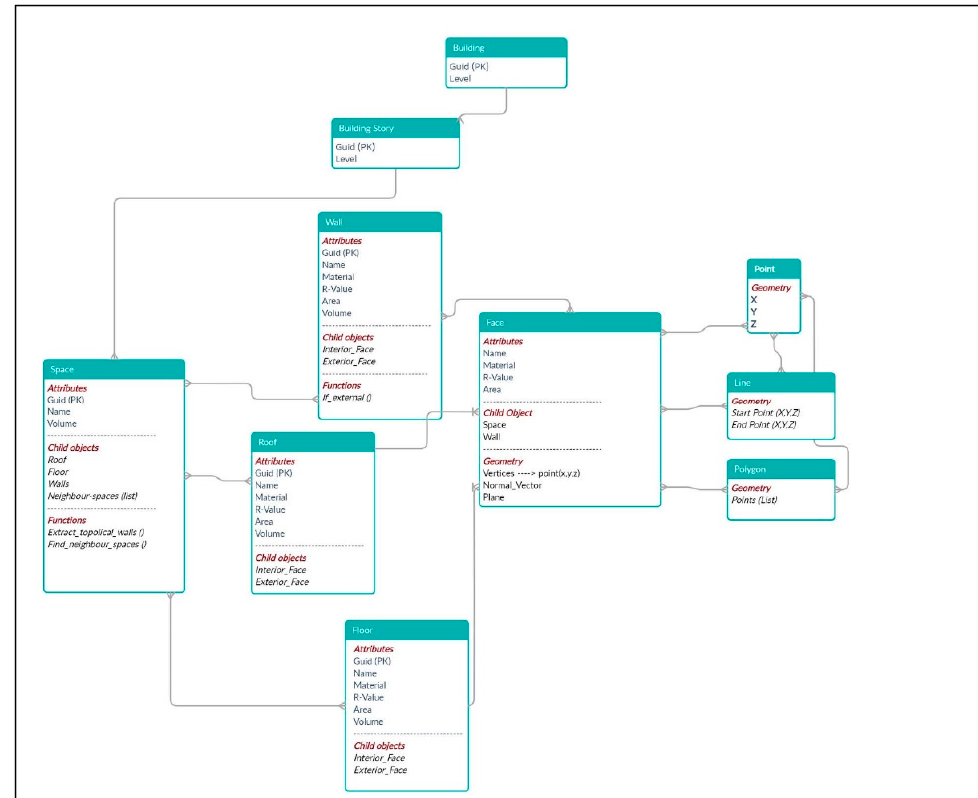
Figure 5. Proposed object-oriented BECE framework from IFC schema .